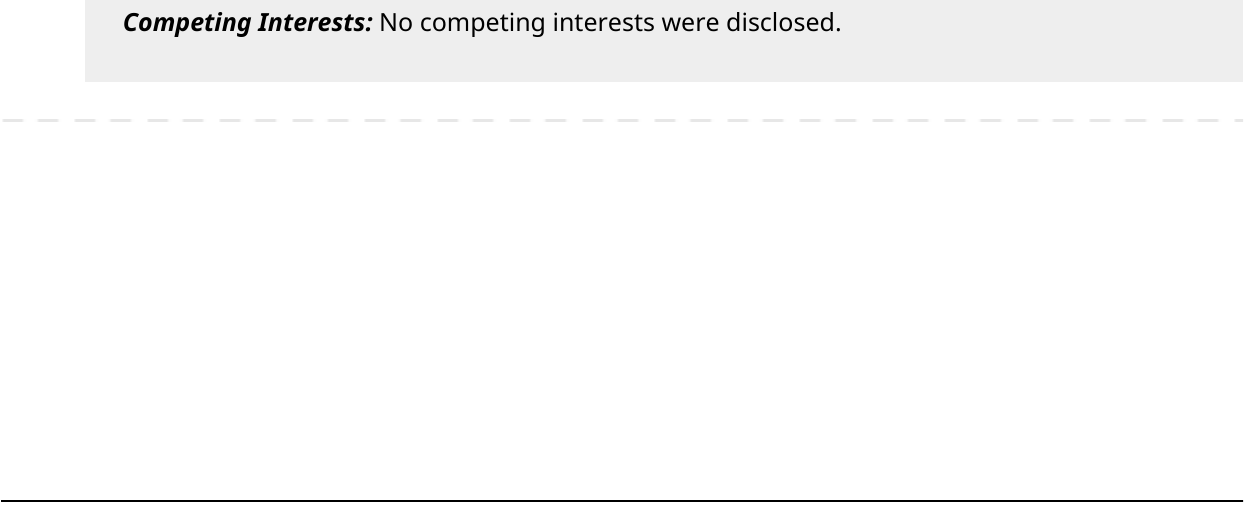
Fig. 1. Standard curves and melt curves. Standard curve of C. albicans ATCC 10231 (A) and representative melt curve graph for C. albicans count in saliva (B) and tongue surface (C) in all participants . The bold fond indicated the added